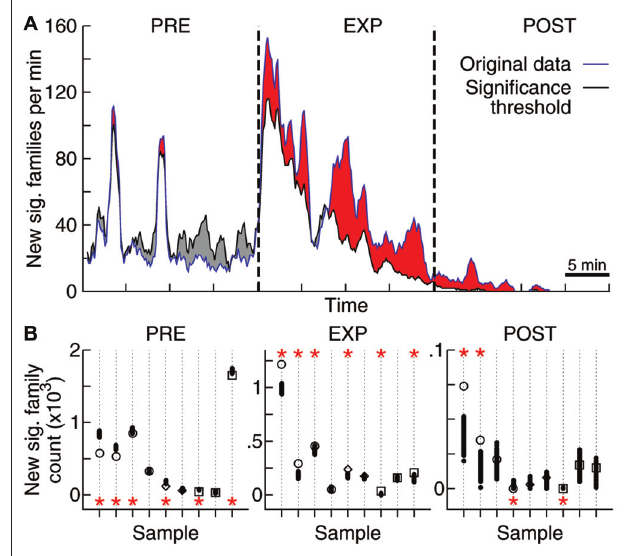
FIGURE 4 | Objects exploration affects repertoire growth. (A) Rate of new significant families observed as function of time. Original data for one sample (blue) as well as the threshold for significance obtained through 1000 label-shuffled sets (black) are shown, with PRE, EXP and POST periods indicated. Red areas represent periods of significant generation rate ( p = 0.05). (B) Total number of families that appeared first in each experiment stage, for each data sample (same order as in Figures 2 , 3 ; open symbols: original data, solid circles: label-shuffled sets). Significant cases ( p = 0.025) are indicated by asterisks on top (high rate) or bottom (low rate) of the